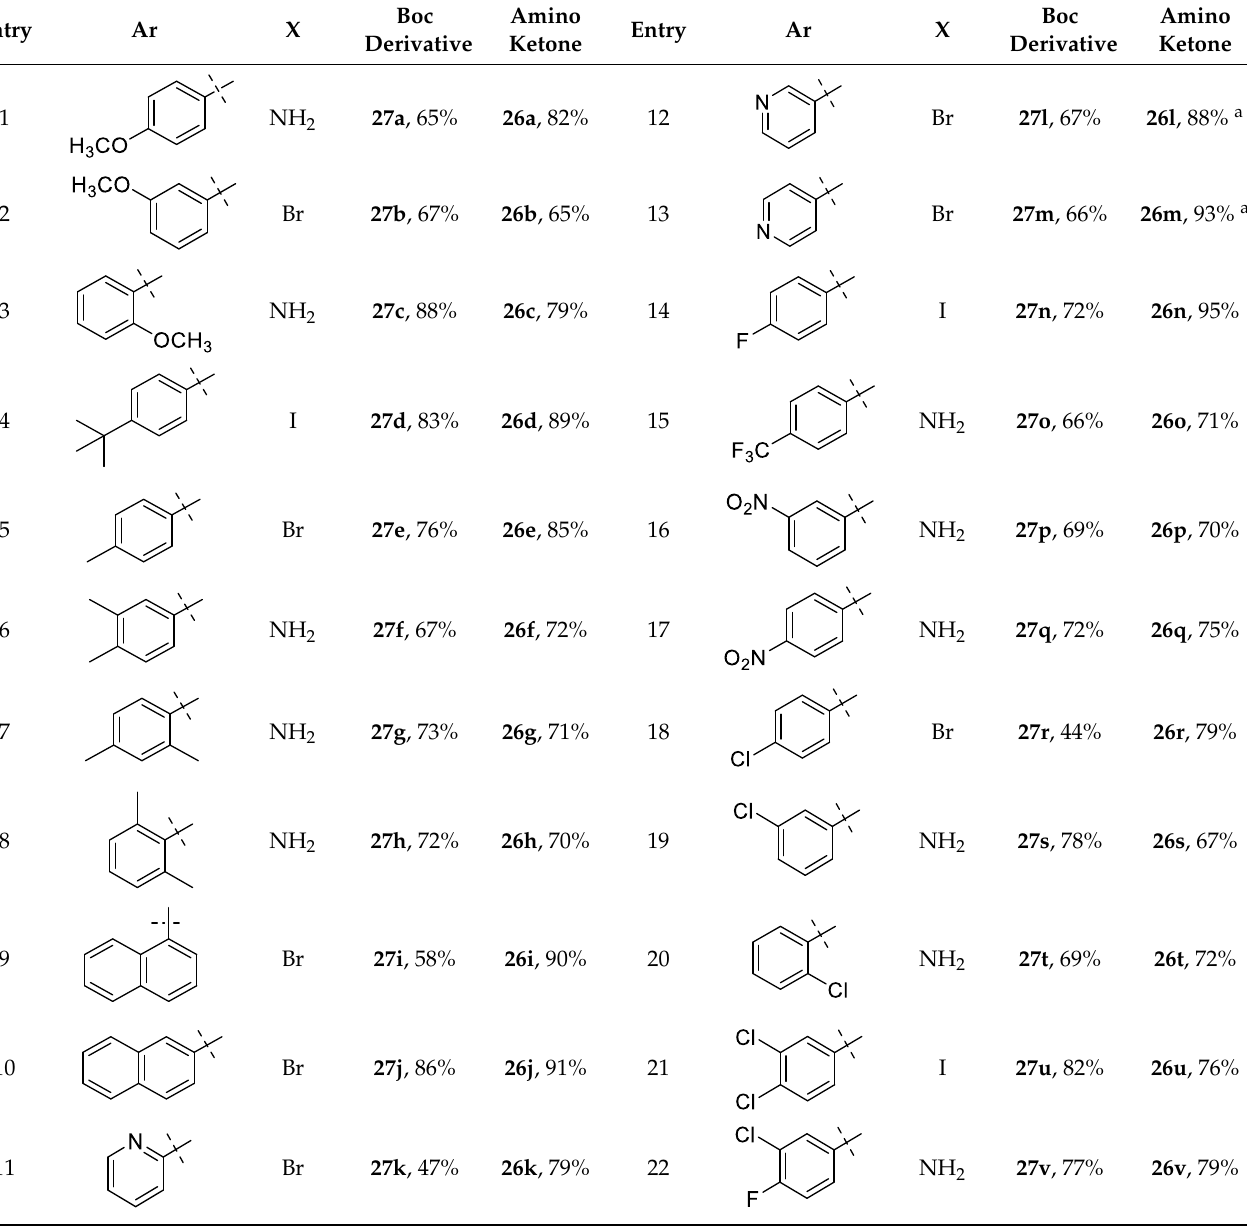
Reagents and conditions: (a) CuI, N , N ’ -dimethylethylenediamine (DMEDA), NaN 3 , sodium ascorbate, EtOH/H 2 O,